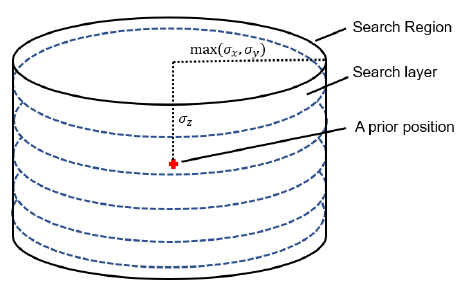
Figure 2. Illustration of the search region around the prior position and the set up of the search layers, where σ x , σ y , σ z is the standard deviation of the a prior position